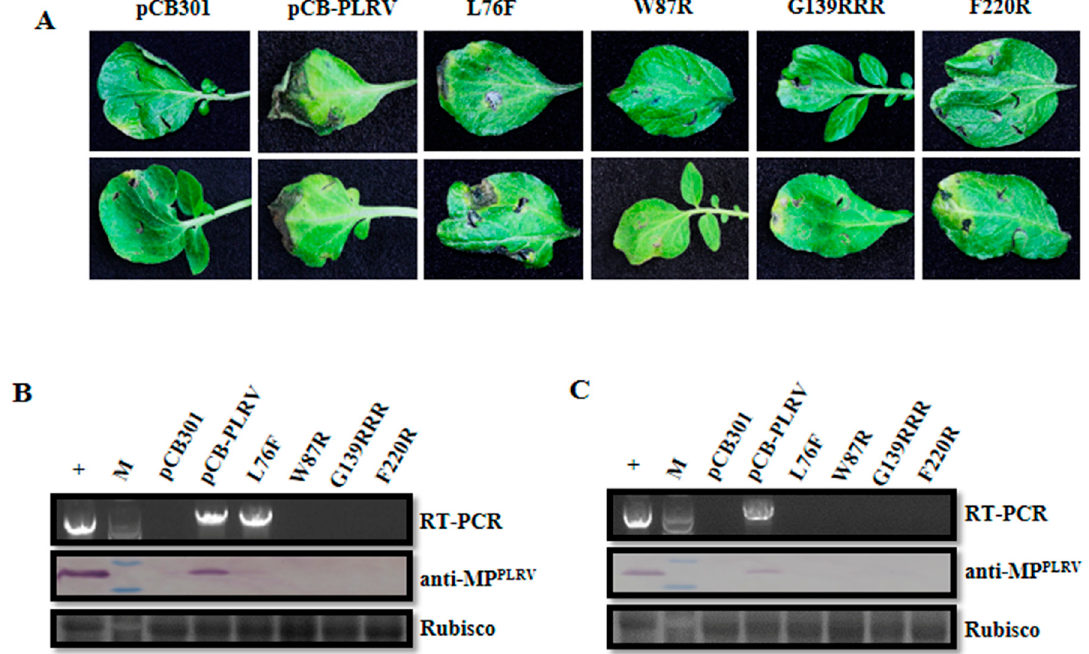
Figure 5. Infectivity analysis of VSR defective mutants in F-box-like motif, G139/W140/G141-like motif, and C-terminal conserved region derived from the pCB-PLRV in potato plants. ( A ) Symptoms on potato (cultivar Lalpakri) leaves agroinfiltrated with pCB empty vector (negative control), wild-type pCB-PLRV (positive control), and mutants pCB-PL-L76F, pCB-PL-W87R, pCB-PL-G139RRR, and pCB-PL-F220R, respectively, at 5 dpi. ( B ) Assessment of the viral RNA and protein accumulation in potato leaves inoculated with pCB-PLRV mutants by RT-PCR amplification and western blot analysis at 3 dpi. ( C ) Assessment of viral RNA and protein accumulation in systemic leaves of potato plants inoculated with pCB-PLRV mutants by RT-PCR amplification and western blot analysis at 14 dpi. Extracts from the inoculated N. benthamiana leaves were used as a positive control. The upper panel shows the RT-PCR amplification with PLRV-specific primer pair. The middle panel shows the western blot analysis with the PLRV-MP specific antibody (anti-MP PLRV ). Rubisco stained with Coomassie brilliant blue used as a loading control is shown in the lower